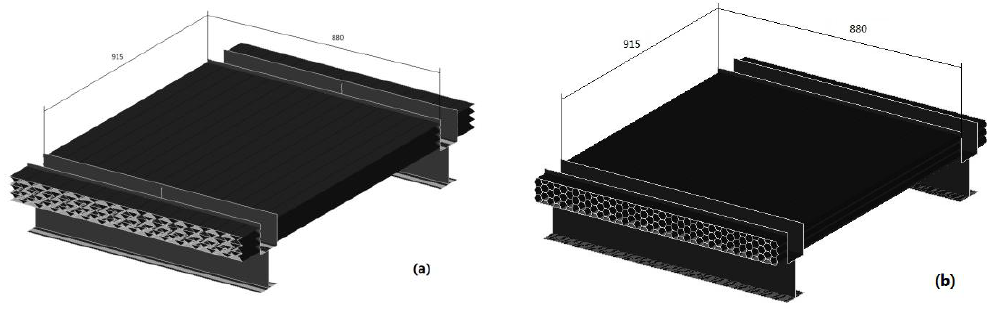
Figure 5. Model diagrams: ( a ) ARBW, ( b ) HSBW.